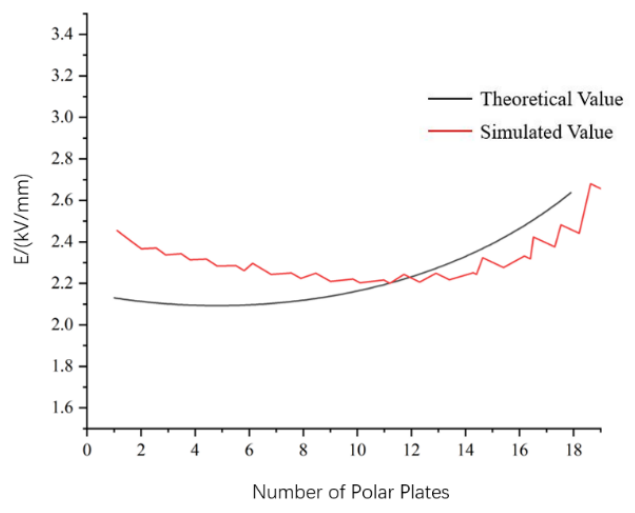
Figure 12. Difference of the simulated value and the theoretical value.